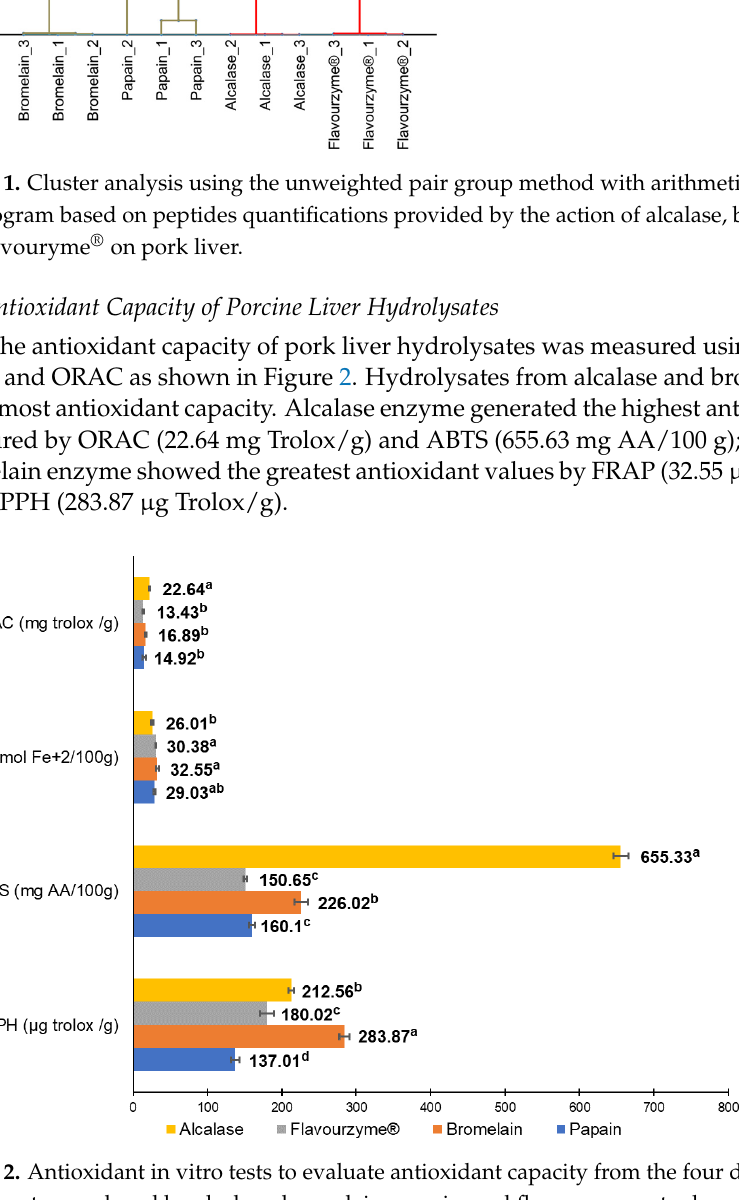
Figure 2. Antioxidant in vitro tests to evaluate antioxidant capacity from the four different pork liver hydrolysates produced by alcalase, bromelain, papain, and flavouryme. a to d upper letters indicate significant differences at p < 0.05 level using Duncan test.